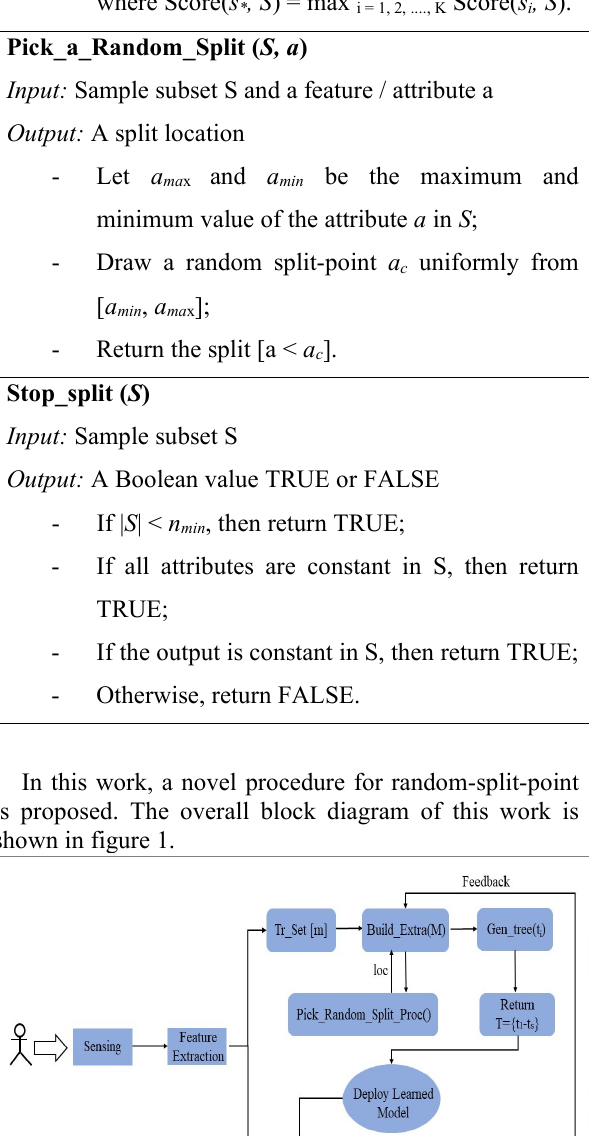
Table 2. Existing Procedure for selecting a random